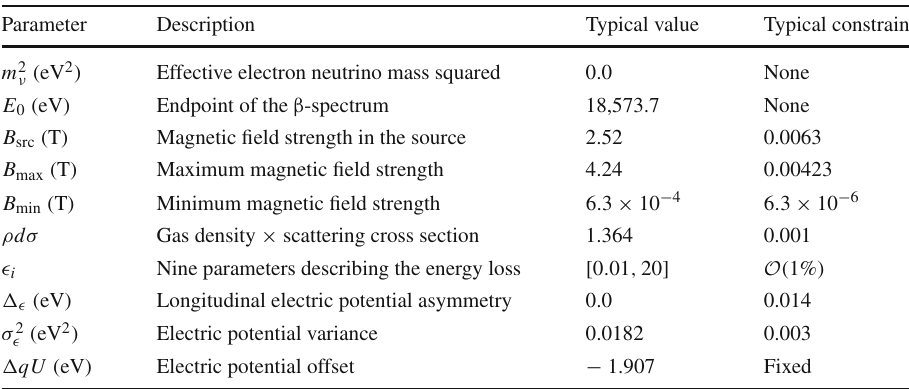
Table 1 Overview of important spectral parameters used in a KATRIN data analysis with their typical value and constraint [13]. Parameters without a constraint are always inferred from the data while the constraint is usually used as 1 σ